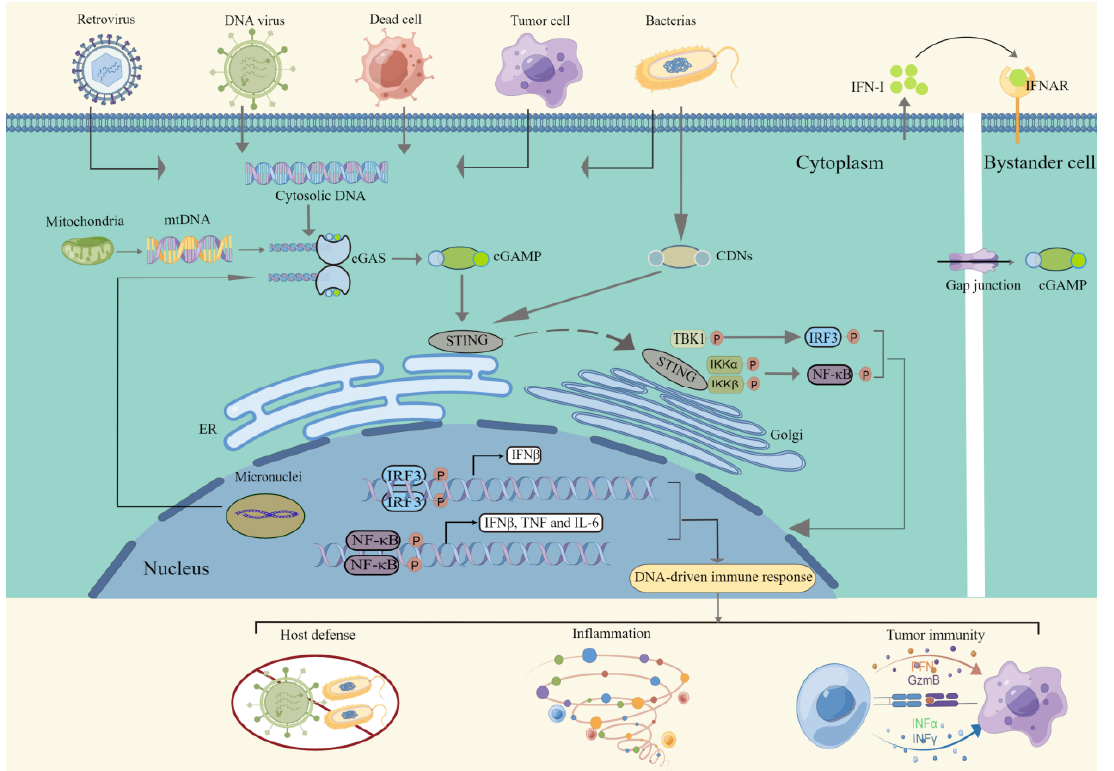
Figure 1. The cGAS‒STING‒TBK1 signaling pathway. Various DNA derived from virus, dying tumor cells or nucleus and mitochondria binds to and activates the cytosolic DNA sensor cGAS. cGAS utilizes GTP and ATP to produce the second messenger cGAMP, which directly binds to the ER-localized adaptor protein STING. Stimuli other than cGAMP, CDNs derived from bacteria can also activate STING. Subsequently, STING alters into a more closed conformation and transfers to the Golgi via the ERGIC, where it binds and activates the kinase TBK1 and IKK, which phosphorylate IRF3 and IκBα, respectively. Then, Phosphorylated IRF3 and IκBα dimerize and enter the nucleus, initiating the transcription of Type I IFN, TNF and IL6. These cytokines play a pivotal role in host defense, inflammation and antitumor immunity. Abbreviations: cGAS, cyclic GMP-AMP synthase; STING, stimulator of interferon genes; TBK1, TANK-binding kinase 1; cGAMP, cyclic GMP-AMP; ER, endoplasmic reticulum; CDNs, cyclic dinucleotides; ERGIC, ER-Golgi intermediate compartment; IKK, IκB kinase; IRF3, interferon regulatory factor 3; TNF, tumour necrosis factor.